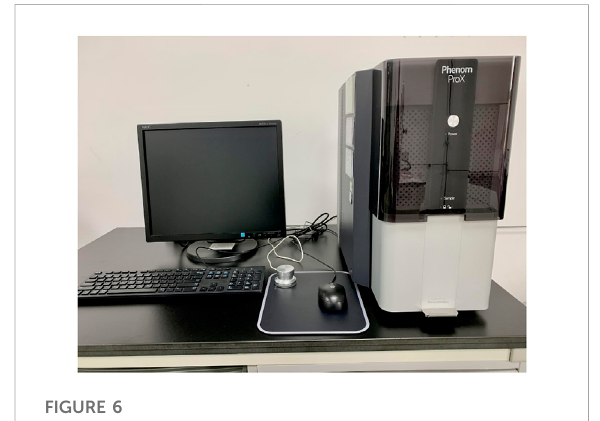
FIGURE 6 Scanning electron microscopes equipment.